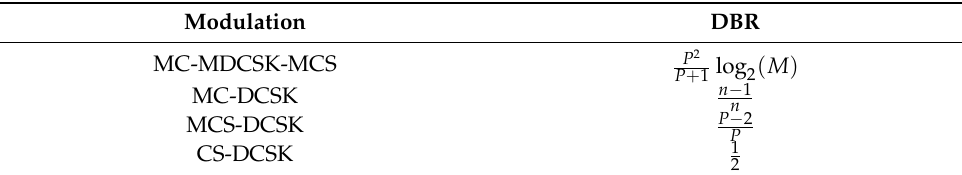
Table 1. Comparisons of DBRs between the proposed MC-MDCSK-MCS system and other DCSK- based chaotic communication